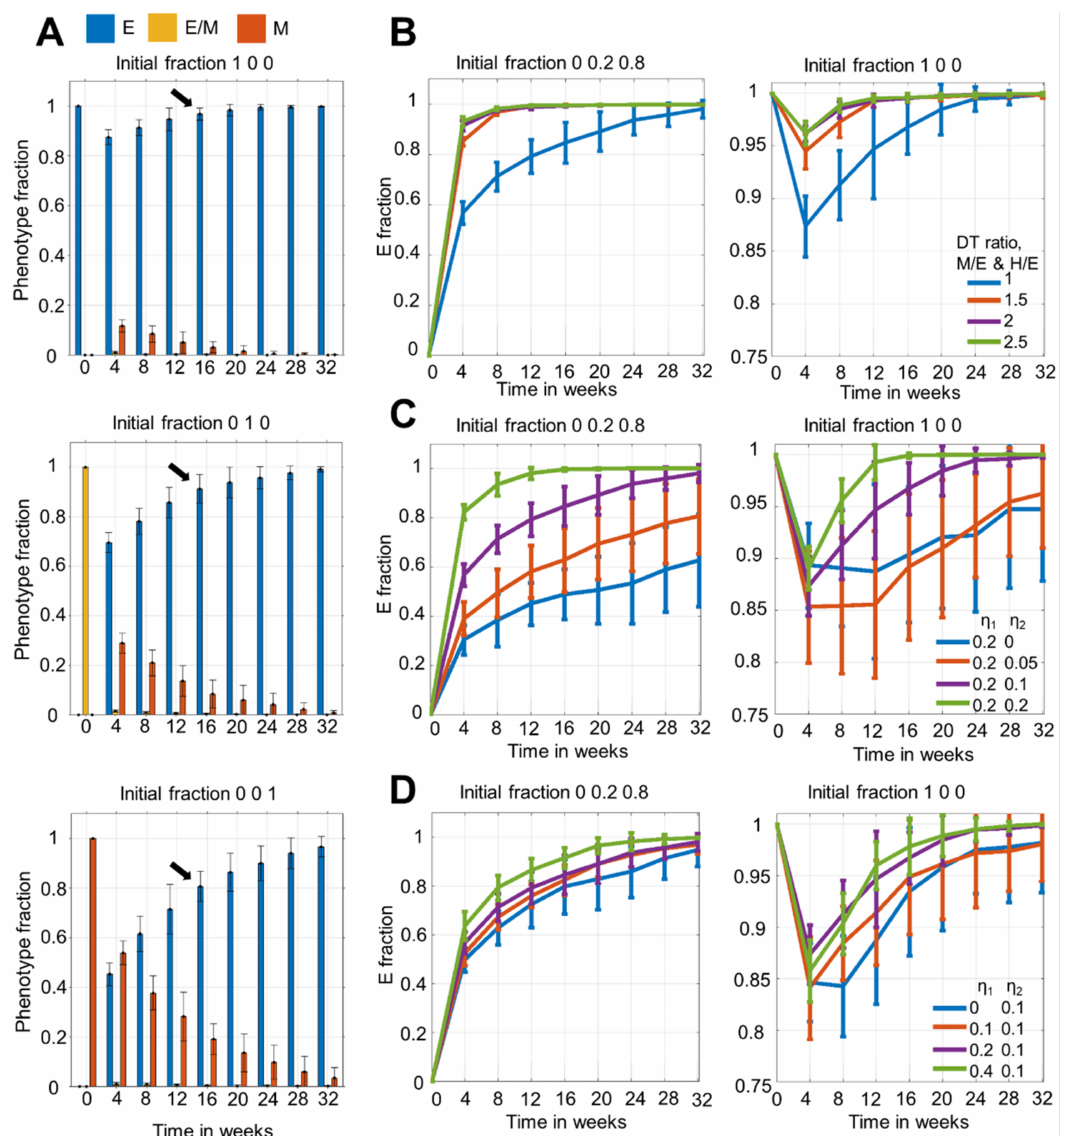
Figure 3. Time to attain dominance of E cells depends on initial fraction and average doubling times of phenotypes, and the extent of molecular fluctuations. ( A ) Temporal changes in phenotypic distribution for purely E, E/M, and M initial population. ( B ) Temporal changes in phenotypic distribution when there is heterogeneity in average doubling time (DT) among phenotypes. DT(E/M, M) = DT ratio ∗ DT(E). η 1 = 0.2, and η 2 = 0.1. ( C ) Temporal changes in phenotypic distribution for fixed η 1 and varying η 2 values. Here, DT(E, E/M, M) = 20 h. ( D ) Same as ( C ) but with varying η 1 and fixed η 2 values. In all, except ( A ), initial fractions of (1) Mix of E/M and M, and (2) pure E phenotypes are considered. The initial population size was 200 cells. Mean and standard deviation calculated from 16 independent